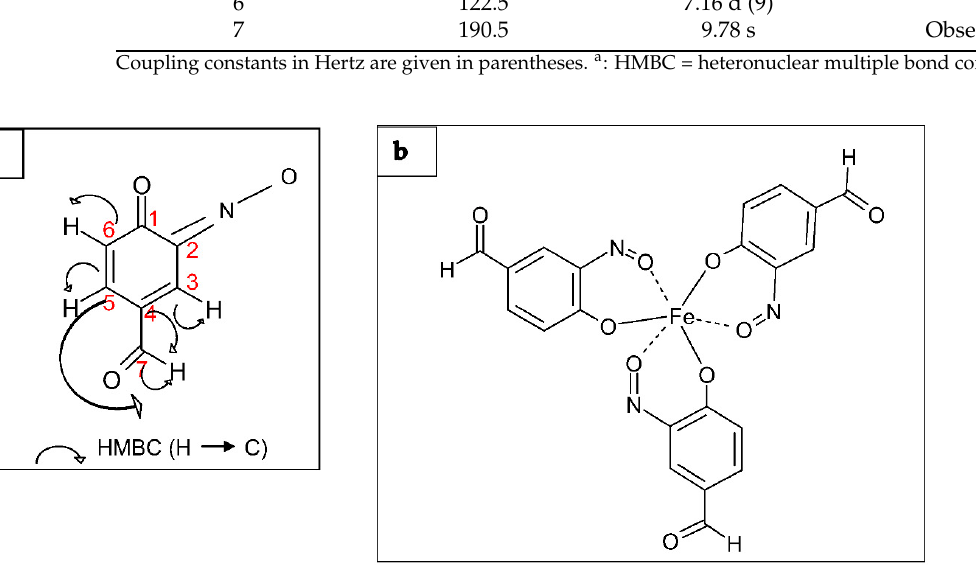
Figure 4. Structure and proposed mode of action of the viridomycin-like D 2 compound ( a ) Monomer of the viridomycin-like D 2 compound and HMBC correlation. ( b ) Proposed mode of action of the compound as an iron chelator.